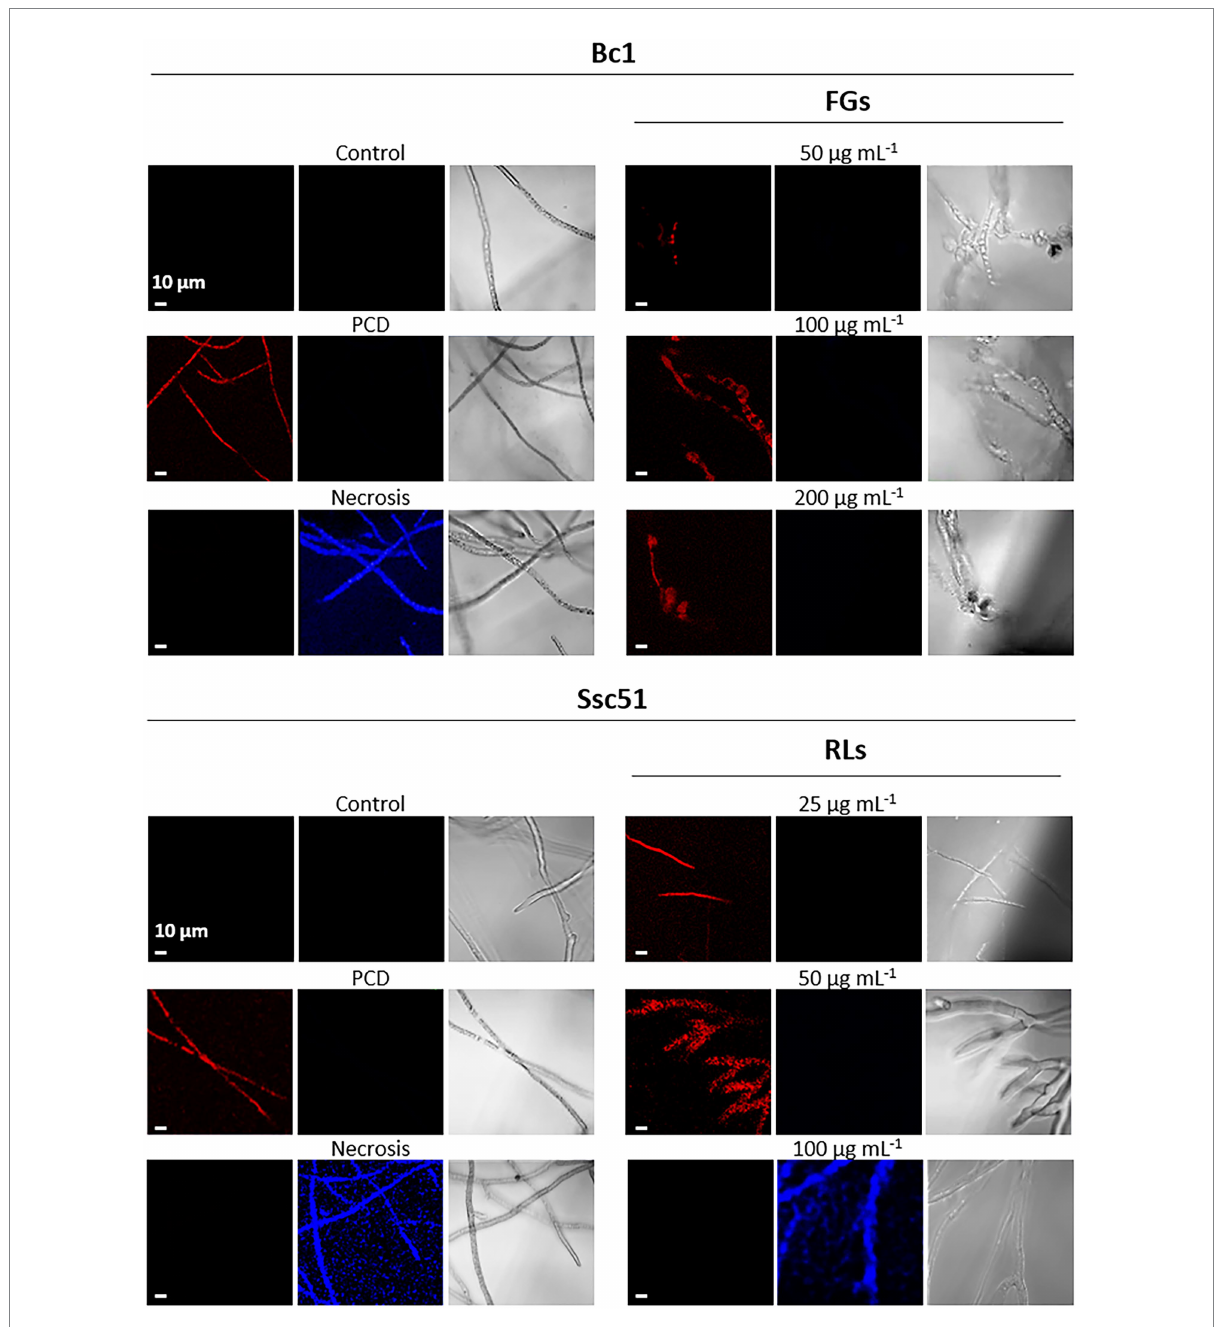
FIGURE 8 Induction of reactive oxygen species (ROS) production by RLs or FGs. Confocal fluorescence microscopy observation of Bc1 and Ssc51 mycelium after treatments with different concentrations of RLs and FGs. Cells were stained with dihydroethydium (DHE). PCD corresponds to mycelium treated with 3 mM hexanoic acid; necrosis corresponds to boiled mycelium. Left and middle panels are fluorescence microscopy images of oxidized DHE (red) and non-oxidized DHE (blue), right panels are light microscopy images. Scale bar: 10 μ